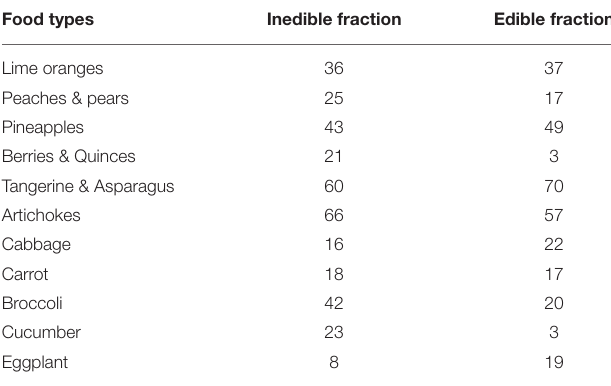
TABLE 1 | Edible and Inedible fractions (%) of some perishable food items (Maletta and Maletta, 2012; Public Health England, 2015). Food